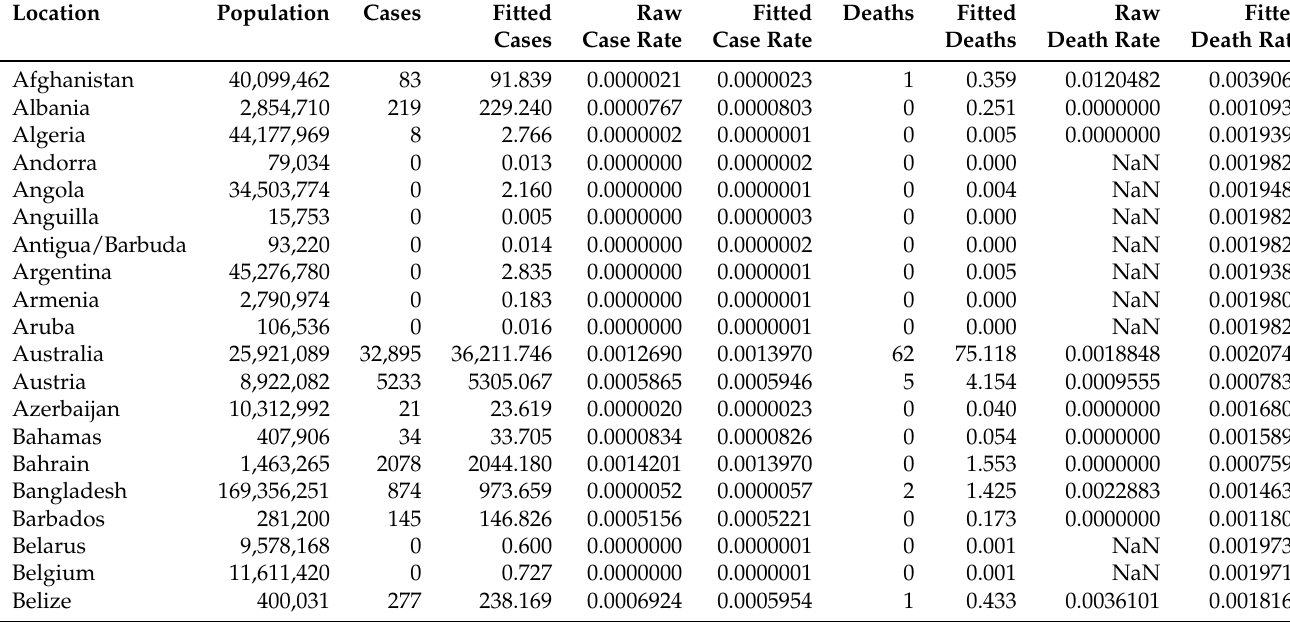
Table 2. Raw and fitted cases, case rates, deaths, and death rates, on Tuesday, 21 June 2022.